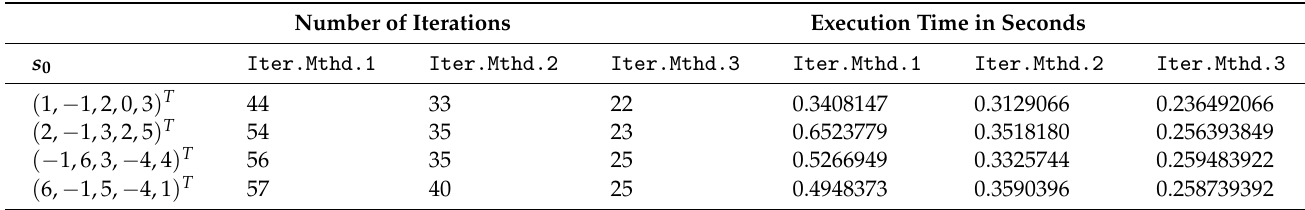
Table 3. The first three techniques have numerical data for Figures 9–16 by using Example